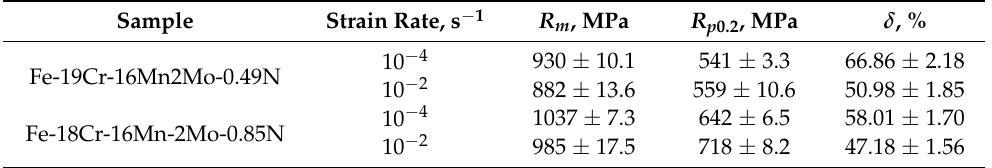
Table 2. Tensile properties of the tested steels tensioned at two strain